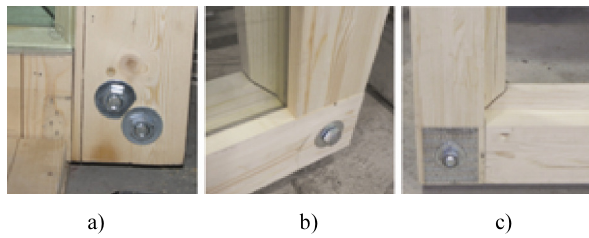
Fig. 1. Details of timber frame joints of type CD1 (a), CD2 (b) and CD3 (c)